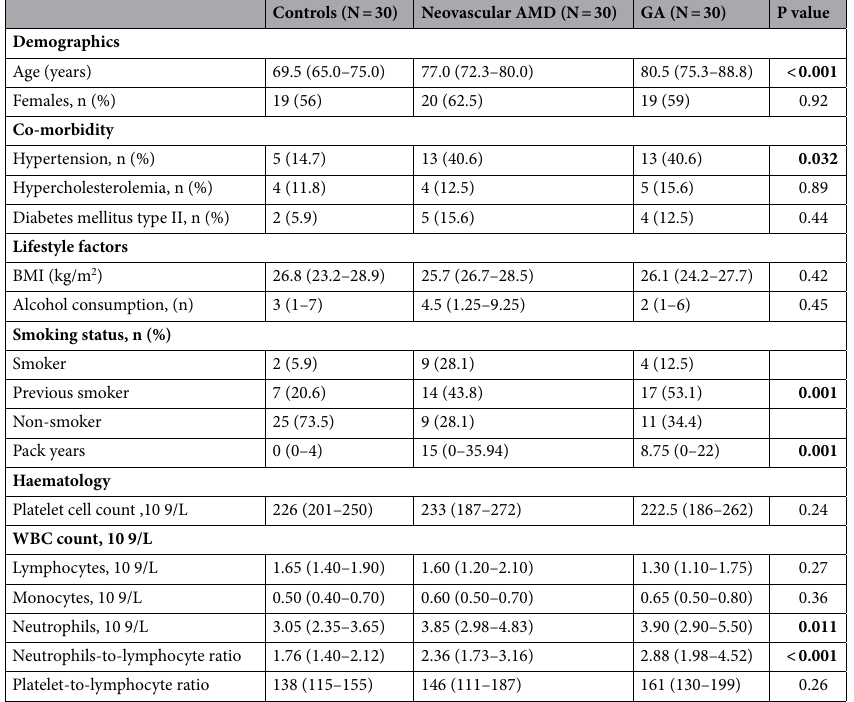
Table 1. Clinical characteristics of patients with either with neovascular AMD or geographic atrophy secondary to AMD and a control series. Data are presented as median values with interquartile ranges, unless otherwise stated. Number of pack-years was calculated as the number of cigarettes smoked per day/20 times the number of years smoked. Bold values indiactes statistical significance at p < 0.05 level.